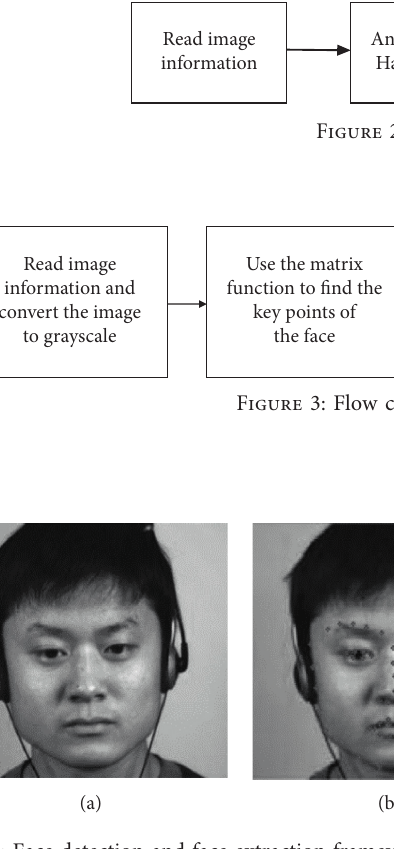
Figure 4: Face detection and face extraction framework. (a) Original image. (b) Face detected with 68 feature points. (c) Facial regions delineated using points 1–27. (d) Thoroughly extracted facial regions.